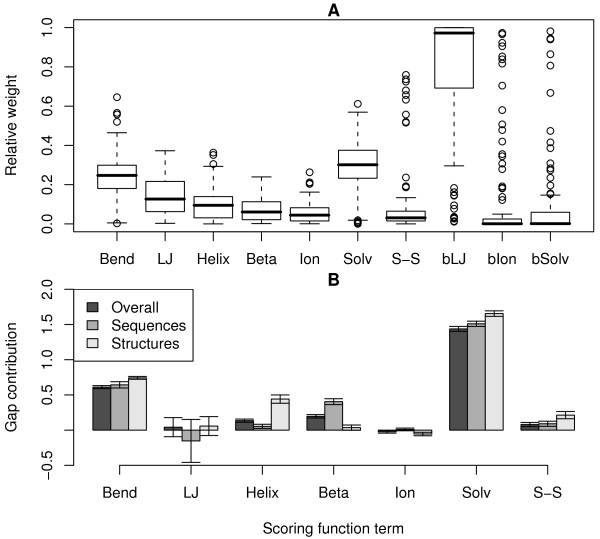
The importance of terms in the physics-based scoring function is shown. A) The distributions of relative weights for each term in the full scoring function on proteins/complexes in the test sets (binding terms prefixed with "b") are depicted. Outliers are shown as empty circles. B) The gap between the native score and the distribution of random samples when using only single terms in the scoring function is depicted. Gaps are shown for the set of random sequences (dark grey), the set of random geometries (light grey) and the combined set (black). Note that only folding score terms are shown.